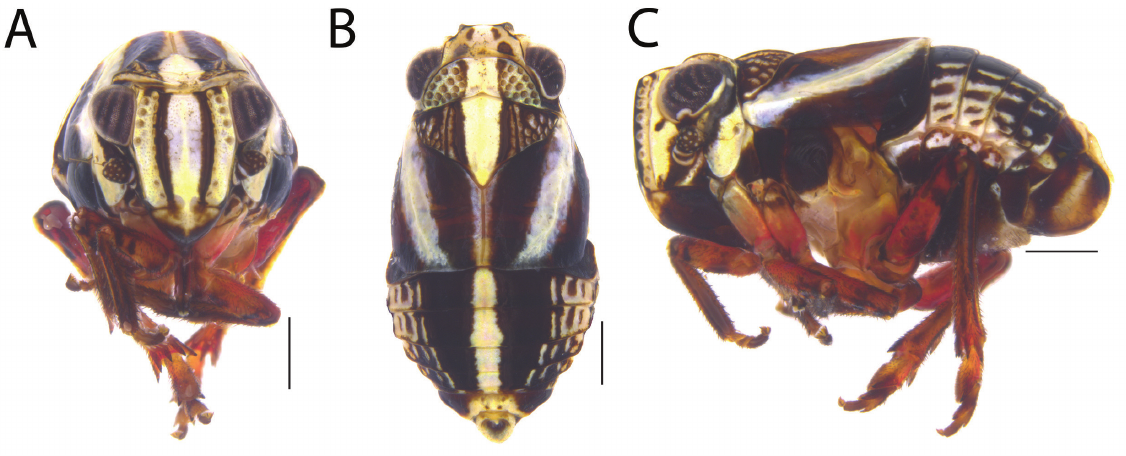
C . Lateral view. Scale bar = 0.5